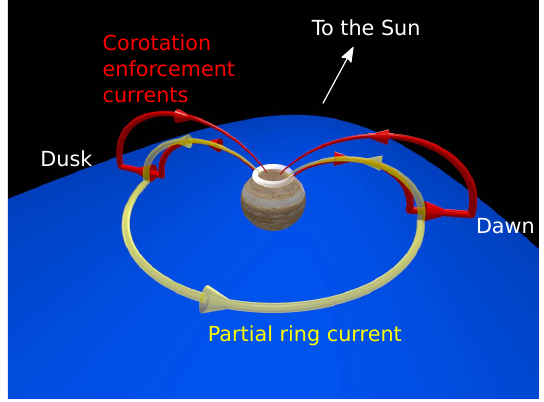
Figure 3. Scheme of the two current systems suggested to affect the main emission brightness. The blue area represents the magne- tosphere and the Sun is towards the top. The corotation enforcement current loops are present at all local times, albeit with varying in- tensity, but only the dawn and the dusk loops are shown. In this il- lustration, the two currents systems are slightly shifted and only the northern current loops are shown for clarity. It can be see that on the dusk side, the currents of the lower latitude field-aligned branches flow in the same direction, thus leading to a brighter aurora, while the currents on the dawn side flow in the opposite direction, leading to a dimmer aurora. For clarity, only the northern current systems are